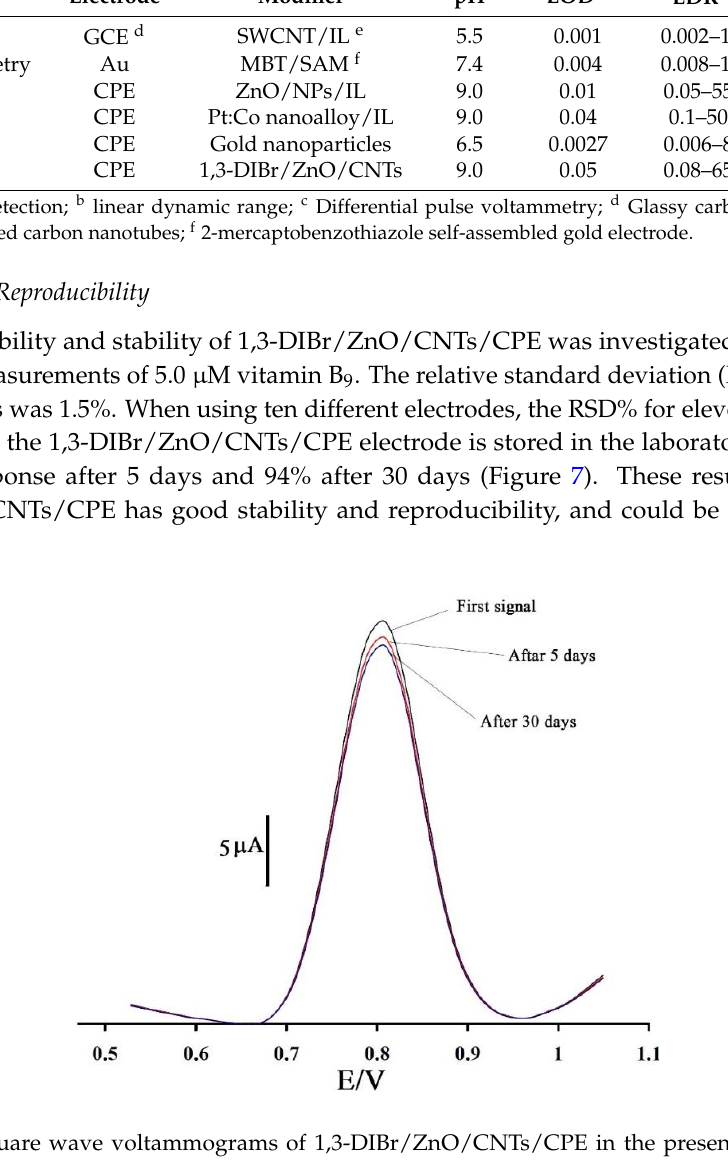
Figure 7. Square wave voltammograms of 1,3-DIBr/ZnO/CNTs/CPE in the presence of 100 μM vitamin B 9 at a pH 9.0 at a different times.